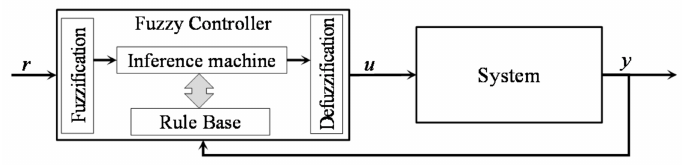
Figure 3. Control system based on a fuzzy